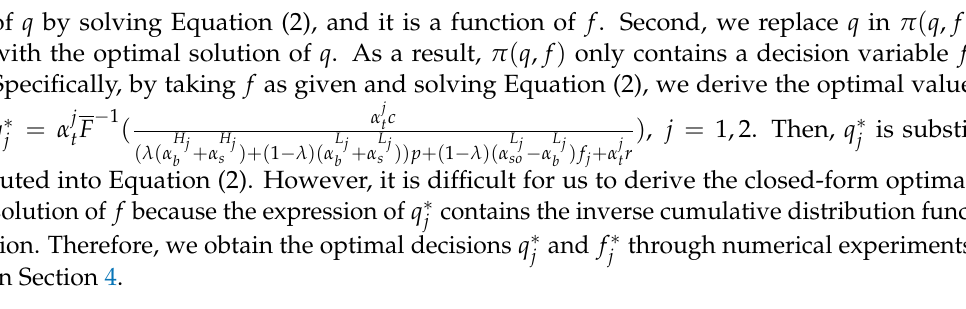
Figure 5. Changes in the brand’s profit with f and q when 0.4 Figure 5 indicates that when